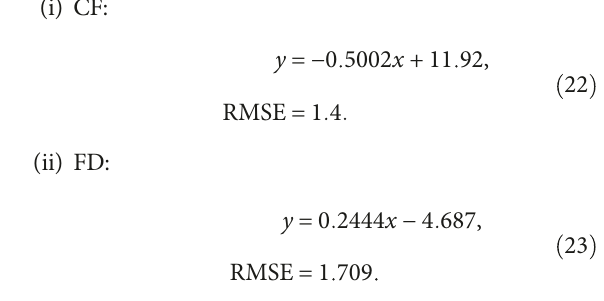
Figure 2: Segmentation point extraction for Table 1: The setting of threshold for d16h20. Slope